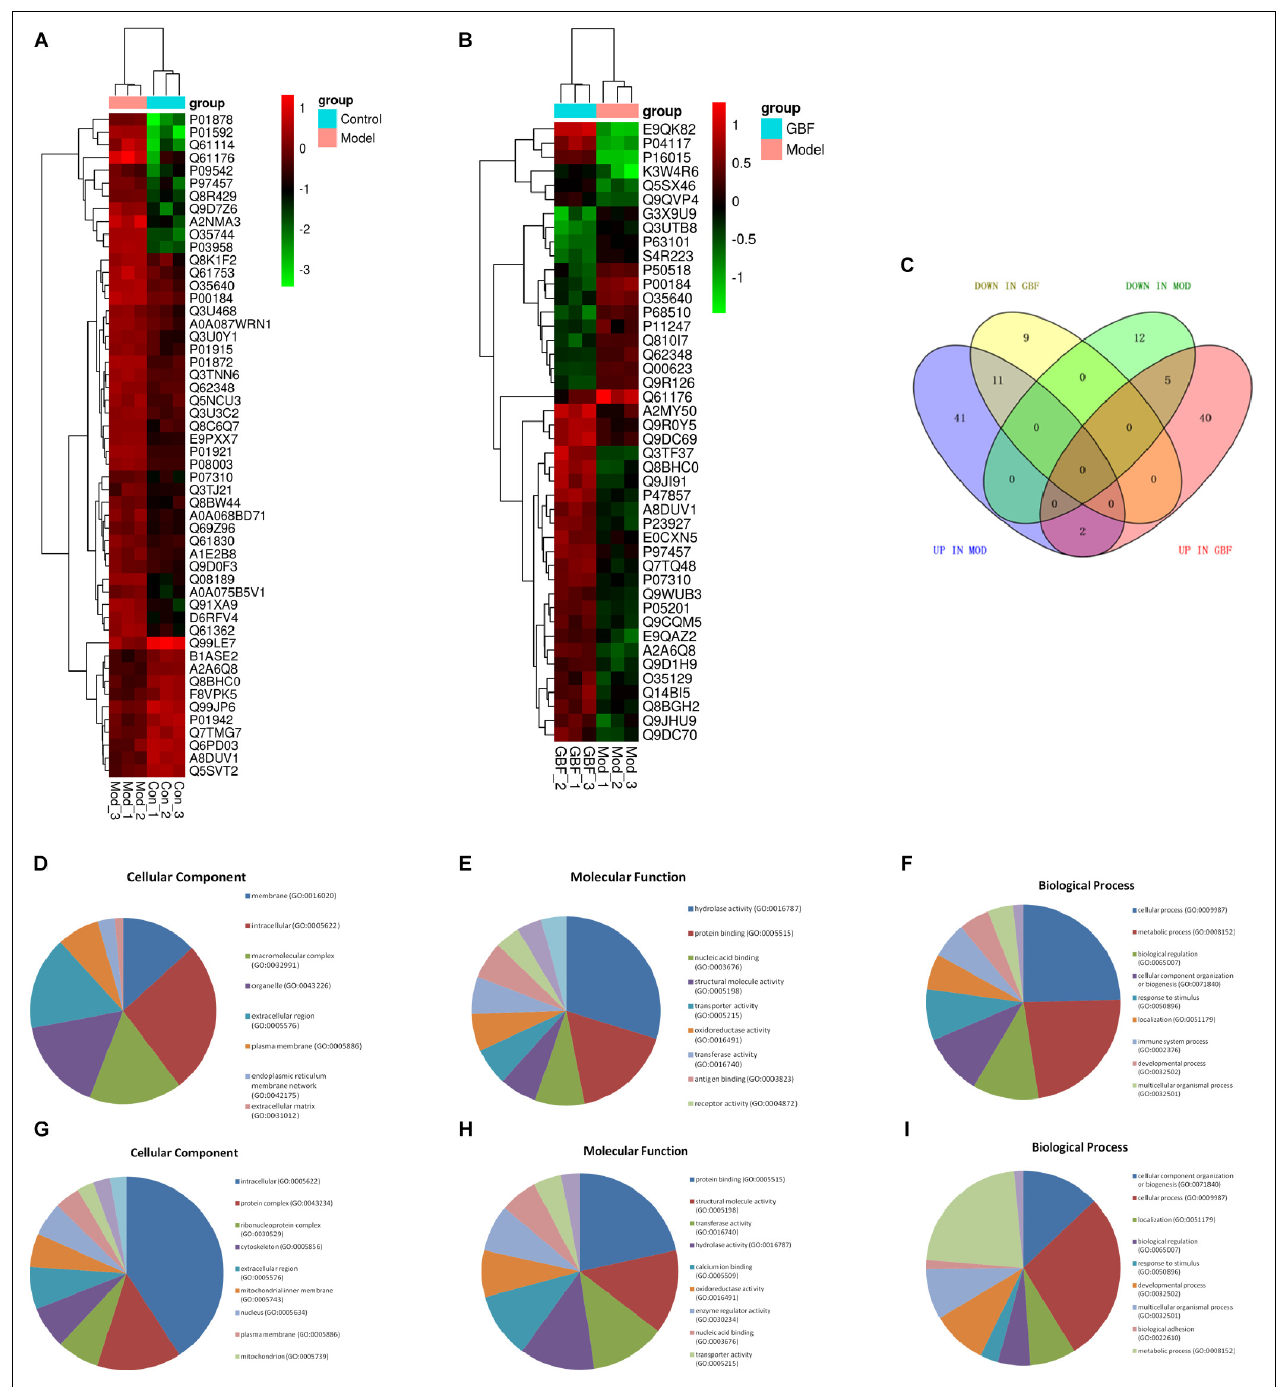
FIGURE 2 | Protein expression profiles. (A,B) Heatmap of the expression levels of differentially expressed proteins (DEPs) compared with those of the model group quantified by iTRAQ-based stable isotope tagging. (C) Venn diagrams showing the distribution of shared DEPs. Blue represents upregulated proteins in the model group (up in MOD), green represents downregulated proteins in the model group (down in MOD), pink represents upregulated proteins in the GBFXD group (up in GBF), and yellow represents downregulated proteins in the GBFXD group (down in GBF). Overlapping sections indicate the number of common proteins across different groups. GO, gene ontology enrichment analysis. GO analysis of DEPs after modeling; (D) biological process, (E) cellular component, and (F) molecular function. GO analysis of DEPs after GBFXD treatment; (G) biological process, (H) cellular component, and (I) molecular function.